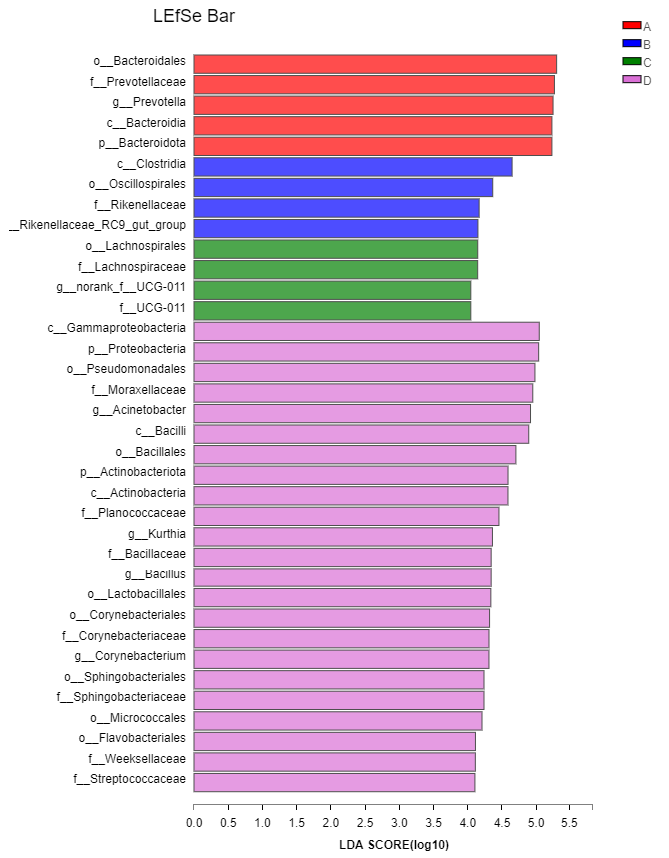
Figure 4. Biomarker bacterial genera in different treatment groups (the control (CON), 70 g/d sodium nitrate (SN), 15 g/d L-methionine (MET), and sodium nitrate group 70 g/d + L-methionine 15 g/d (SN+MET) groups) as revealed by linear discriminant analysis (LDA) Effect Size (LEfSe)-based analysis (LDA score> 4.0).